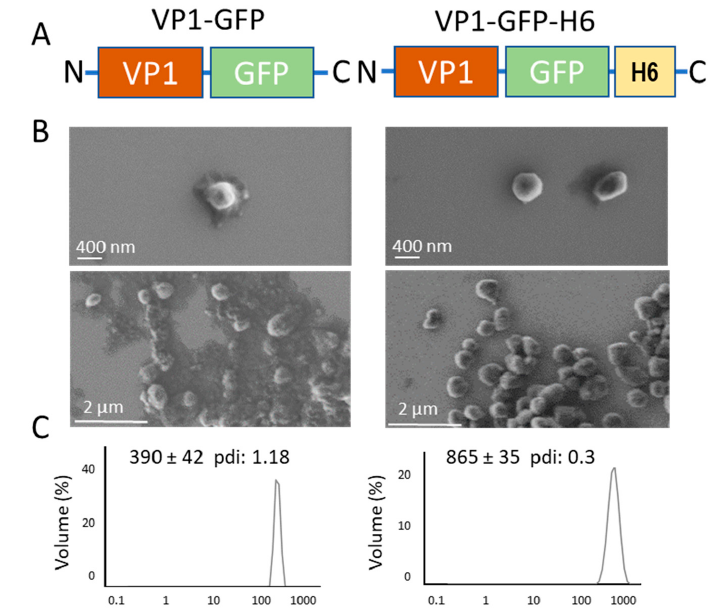
Figure 1. Characterization of bacterial IBs. ( A ). Modular organization of the IB ‐ forming proteins from N ‐ to C ‐ terminal ends. Box sizes are only approximate. ( B ). Representative FESEM images of detail and overview of isolated IBs. ( C ). Hydrodynamic radio of isolated IBs determined by DLS and represented through volume distribution.